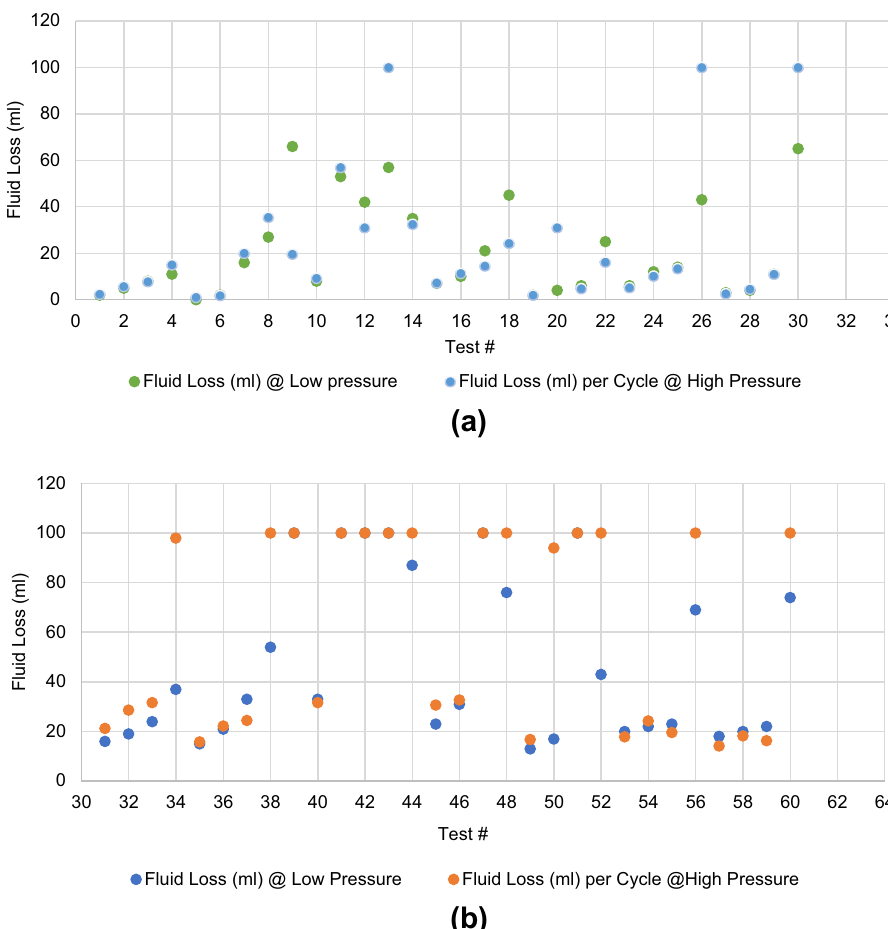
Fig. 31 Comparison between fluid loss values from the LPA and the calculated average fluid loss per cycle from HPA using C1 and